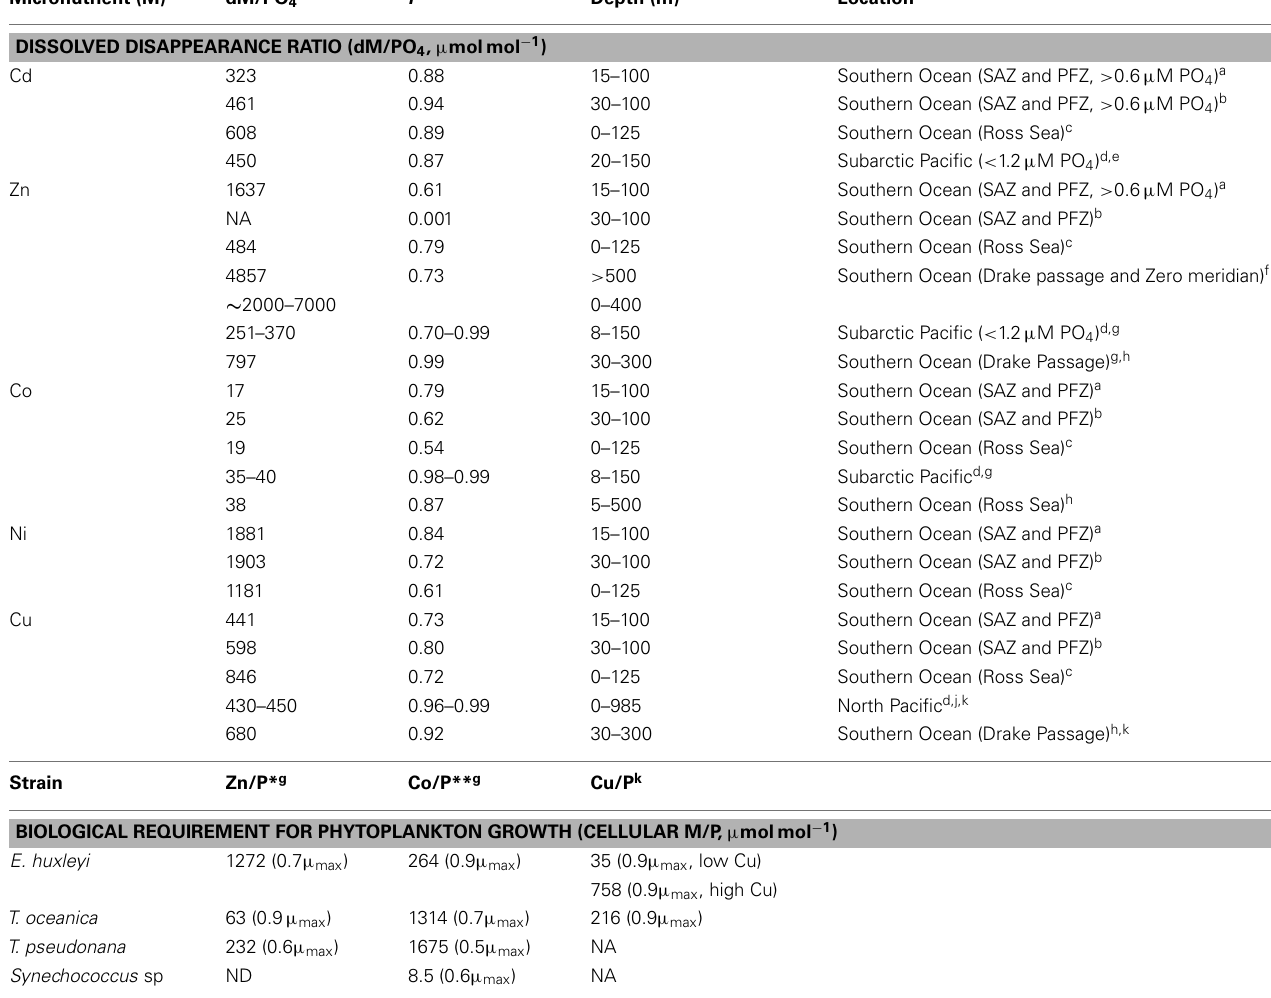
Table 3 | Summary of dissolved disappearance ratios and biological requirement for phytoplankton growth for Cd, Zn, Co, Ni, and Cu. Micronutrient